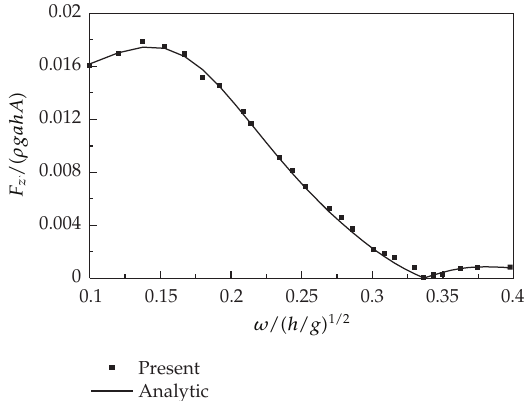
Figure 7: Vertical wave force on cylinder.